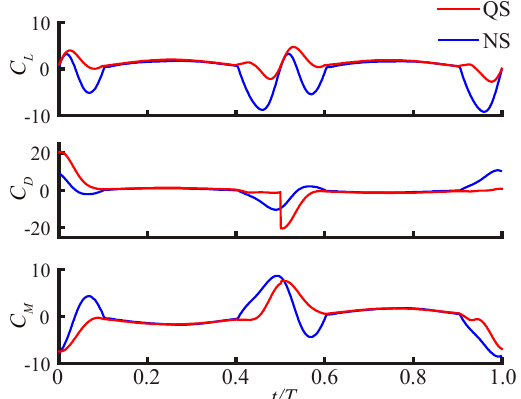
Figure 14. Plots of coefficients of lift ( top ), drag ( middle ), and moment ( bottom ) over one stroke for QS (red) and NSe (blue) predictions for the largest difference motion. In the figure the cycle-averaged lift coefficient for the QS is 1.11 and the NSe is − 0.59. A = 60°, Δ τ r = 0.2 and x pa = 1.0. (0.0 < t / T < 0.1), (ii) middle of forward stroke (0.1 < t / T < 0.4), and (iii) end of forward stroke (0.4 < t / T < 0.5). Figure 15. Plots of the translational (black), added mass (red), rotational (blue) and theoretical rotational (blue dashed), added mass and rotational lift forces in the QS model for the largest difference motion. A = 60°, Δ τ r = 0.2, and x pa = 1.0. The first interval starts at the beginning of the forward stroke and ends when the first part of the pitching motion stops and the pitching angle is held constant at A = 60°. This portion of the stroke is dominated by the rotational component of lift, due to the large pitching amplitude and short pitching duration. The translational velocity is still relatively slow and, therefore, the translational lift component much smaller. The translational component has a small peak due to the pitching axis being at the trailing edge, which means the wing is rotating in the direction of the flapping motion. In the second portion of the stroke, the translational component of lift dominates. Both the rotational and added mass contributions vanish due to the constant pitch angle. The translational component peaks at the midstroke, where the flapping velocity is the highest. The QS solution agrees well with the NSe results. In the third interval, the trends are similar as in the first interval. The signs of the rotational and added mass contributions are opposite, because of the pitch up motion. As the wing rapidly pitches up while decelerating, negative lift is generated. The QS model predicts an increase in lift coefficient and then drops off. The NSe model predicts the lift coefficient to decrease as soon as the pitching begins at t / T = 0.4. The major differences in the lift coefficient occur during the rapid pitch motion where the rotational component is dominant. A phase shift and a difference in magnitude is observed, suggesting that the rotational term in the quasi-steady model is not accurate for the considered kinematics. Note that the use of the theoretical rotational lift coefficient C rot , theo = π worsens the